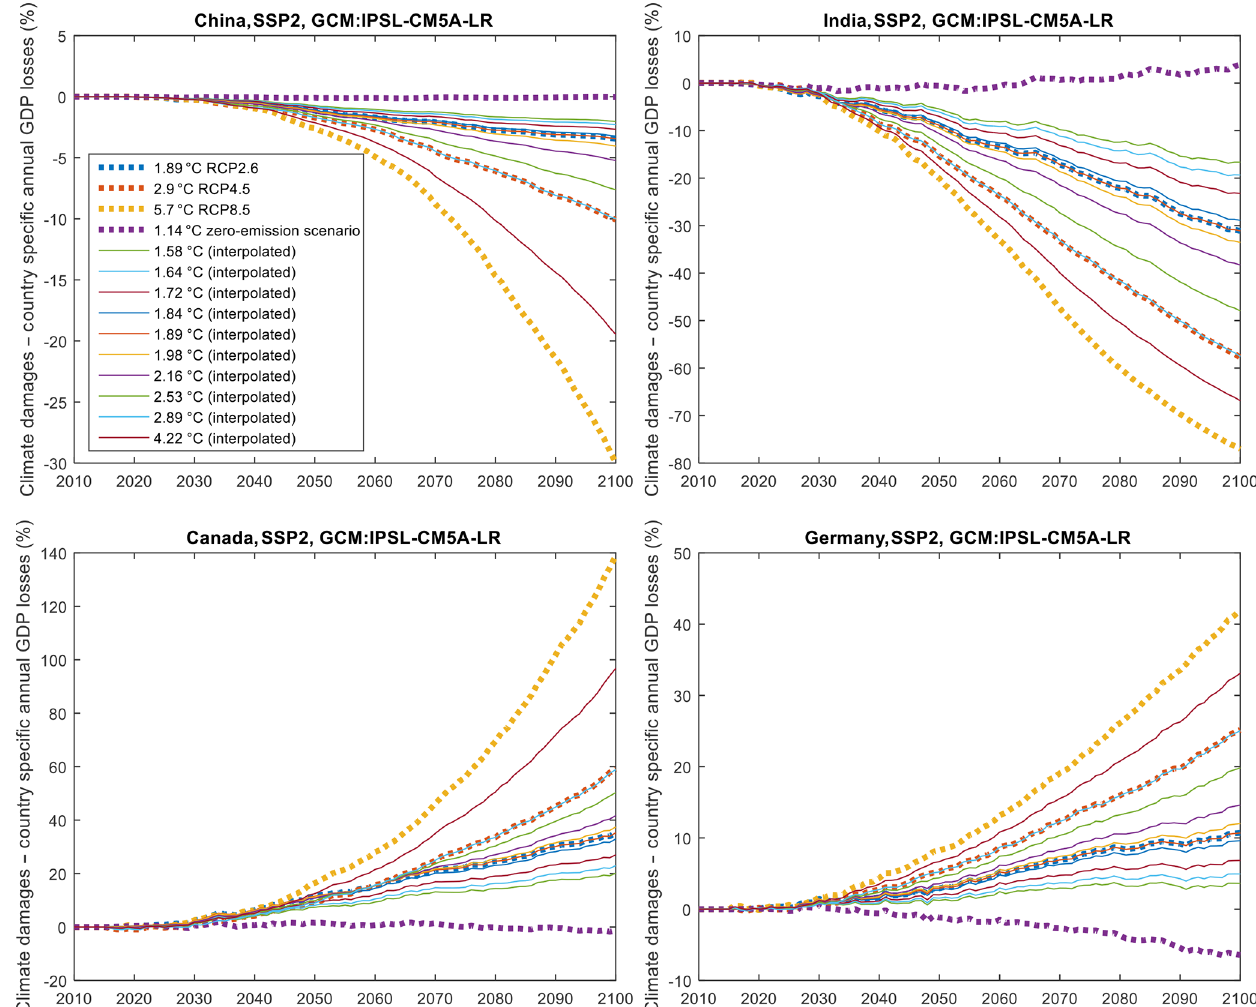
Figure A1. Annual GDP losses from climate-change damages for four countries (China, India, Canada, Germany) and different maximum global warming levels (see legend) of three RCPs, the zero-emission scenario (dashed lines), and 10 interpolated scenarios that correspond to the warming limits of the REMIND mitigation scenarios. Negative values correspond to